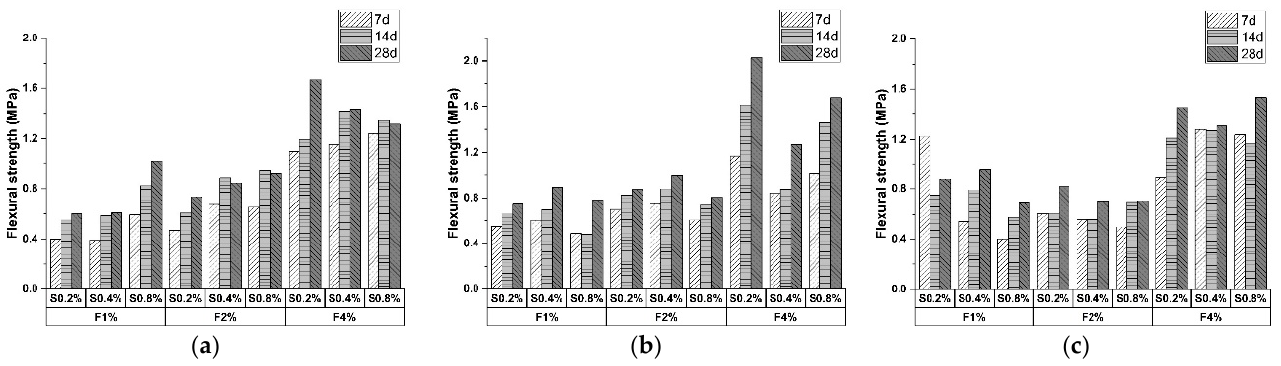
Figure 8. Flexural strength of 30% cement specimen with ( a ) 10% C&D waste; ( b ) 20% C&D waste; ( c ) 30% C&D waste (Note: S represents sodium sulfate; F represents polypropylene fiber).